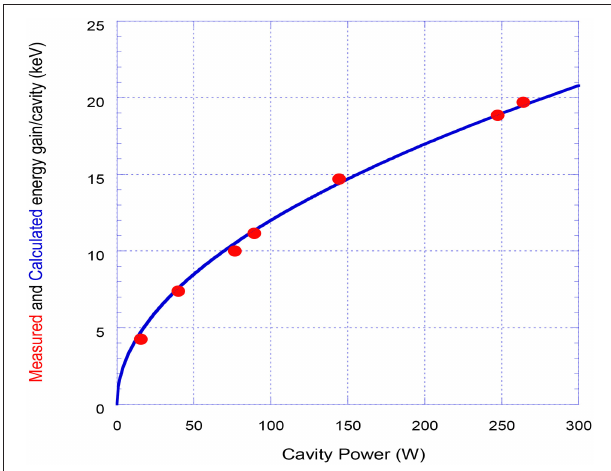
FIGURE 14 | Plot of measured (red circles) and calculated (blue line) energy gain vs. cavity power.